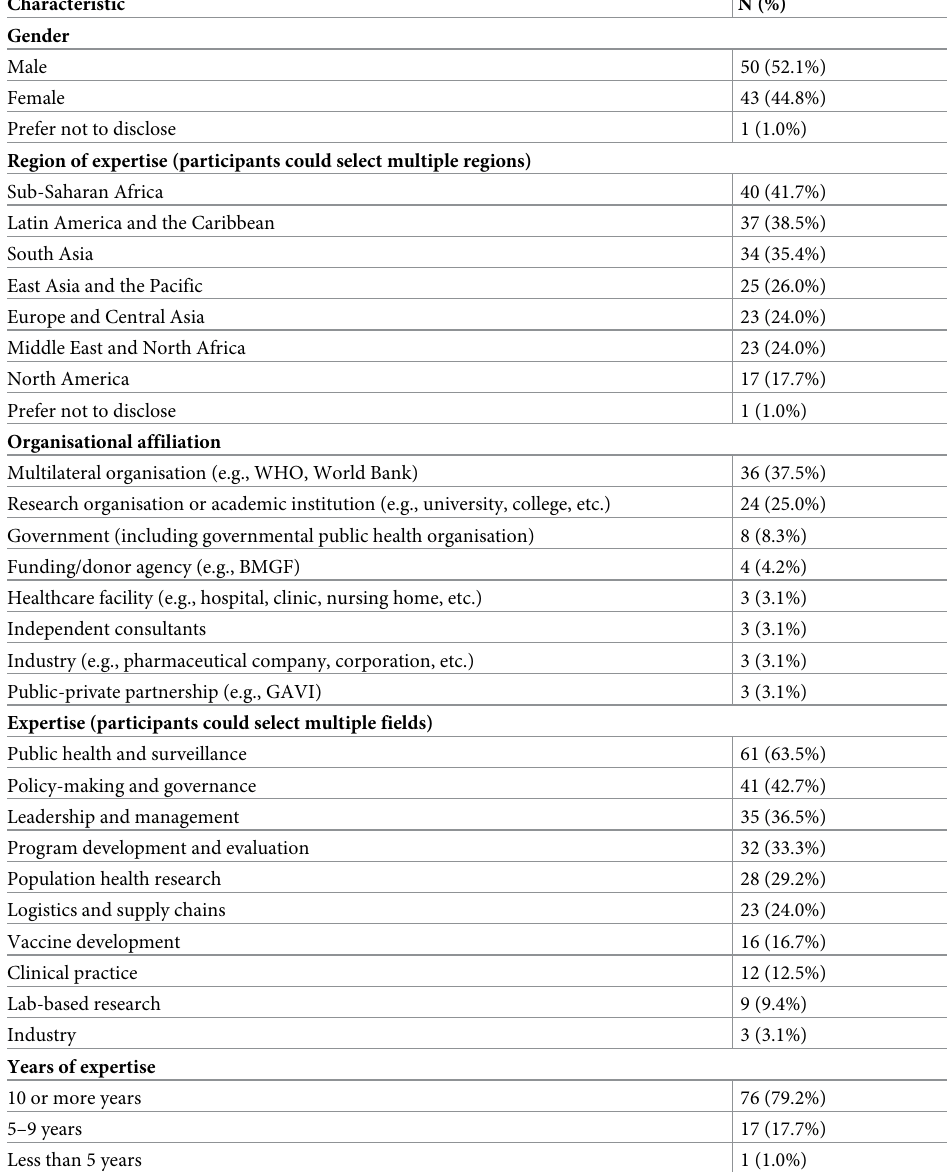
Table 1. Baseline characteristics of